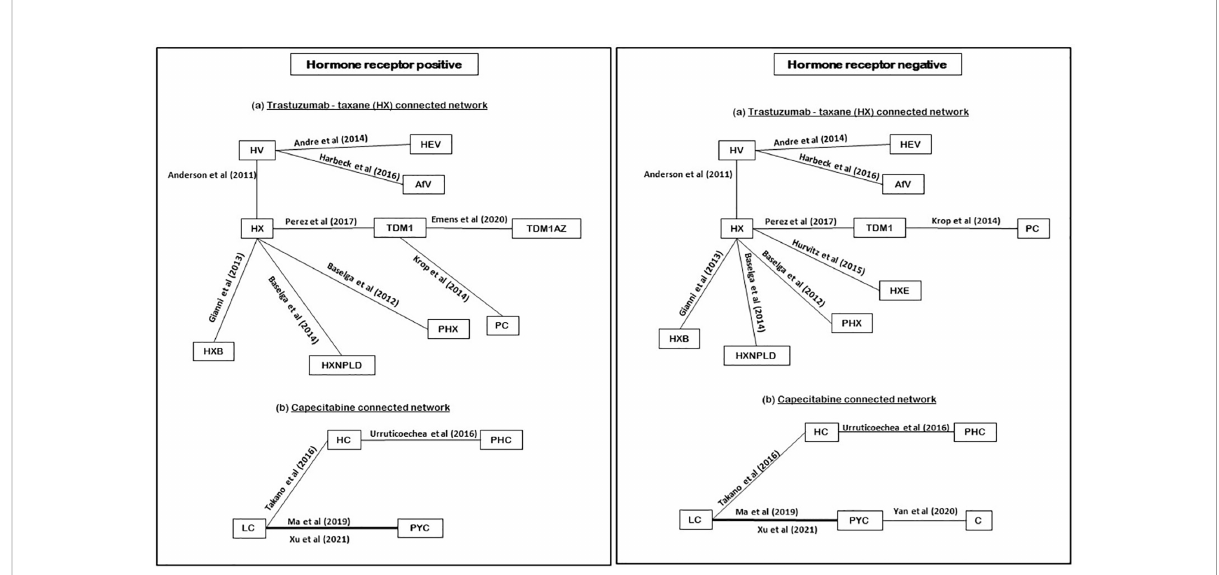
FIGURE 4 Network plot of hormone receptors subgroup RCTs (reporting PFS). PHC, pertuzumab + trastuzumab + capecitabine; PC, physician choice; LC, lapatinib + capecitabine; TDM1, trastuzumab emtansine; C, capecitabine; PYC, pyrotinib + capecitabine; HC, trastuzumab + capecitabine; TDM1AZ, trastuzumab emtansine + atezolizumab; HX, trastuzumab + taxane; HXB, trastuzumab + taxane + bevacizumab; LX, lapatinib + taxane; HV, trastuzumab + vinorelbine; HXE, trastuzumab + taxane + everolimus; PHX, pertuzumab + trastuzumab + taxane; AfV, afatinib + vinorelbine; HEV, trastuzumab + everolimus + vinorelbine; HXNPLD, trastuzumab + taxane + NPLD; NPLD, non-pegylated liposomal